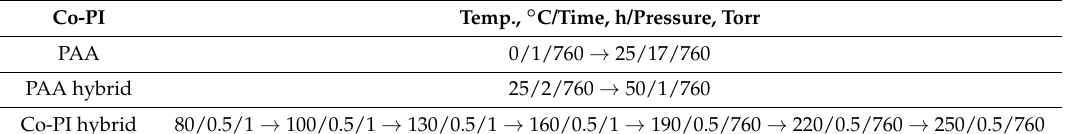
Table 2. Thermal imidization conditions during the preparation of the Co-PI